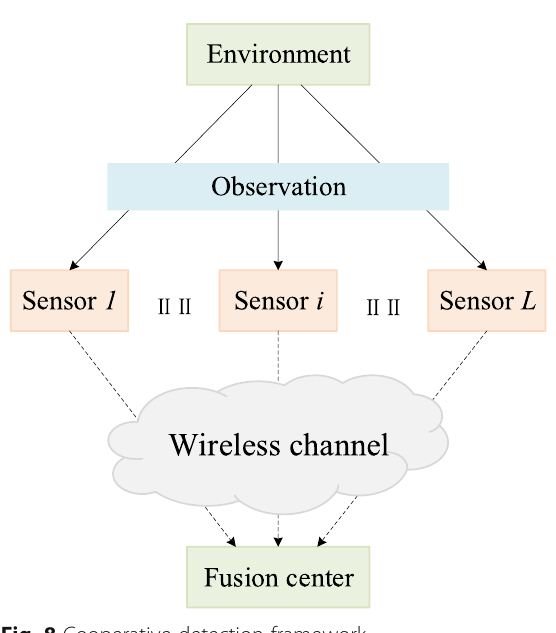
Fig. 8 Cooperative detection